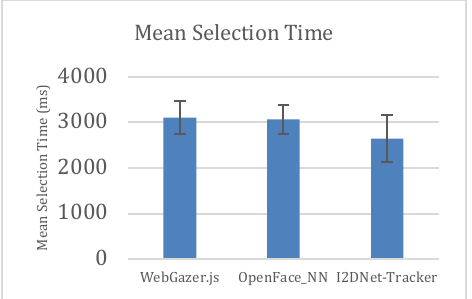
Figure 6. Mean Selection time using three gaze prediction systems.